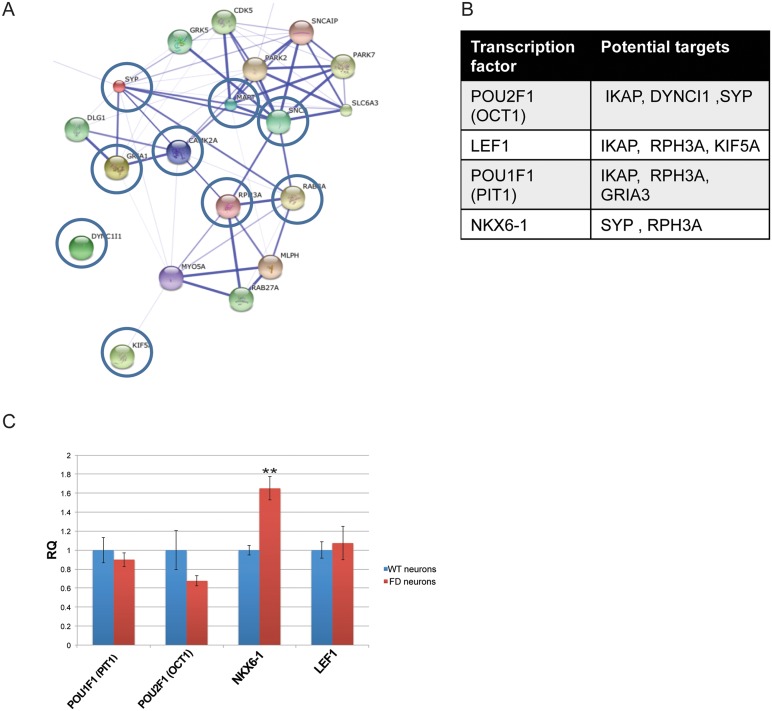
Prediction analysis of networks and transcription factors regulating IKBKAP and IKBKAP co-regulated functional candidate genes.“String” analysis of protein networks showing the potential interaction between the majority of the IKBKAP co-regulated functional candidate genes. (B) Prediction of transcription factors (TF) related to IKBKAP and co-regulated functional candidate genes. (C) Shows relative quantification levels represented as mean ± s.d. of TF gene candidates taken from the total cDNA microarray analysis showing difference between WT and FD-hESC derived PNS neurons. * P<0.05 **P<0.01, Non statistical significance (NS).